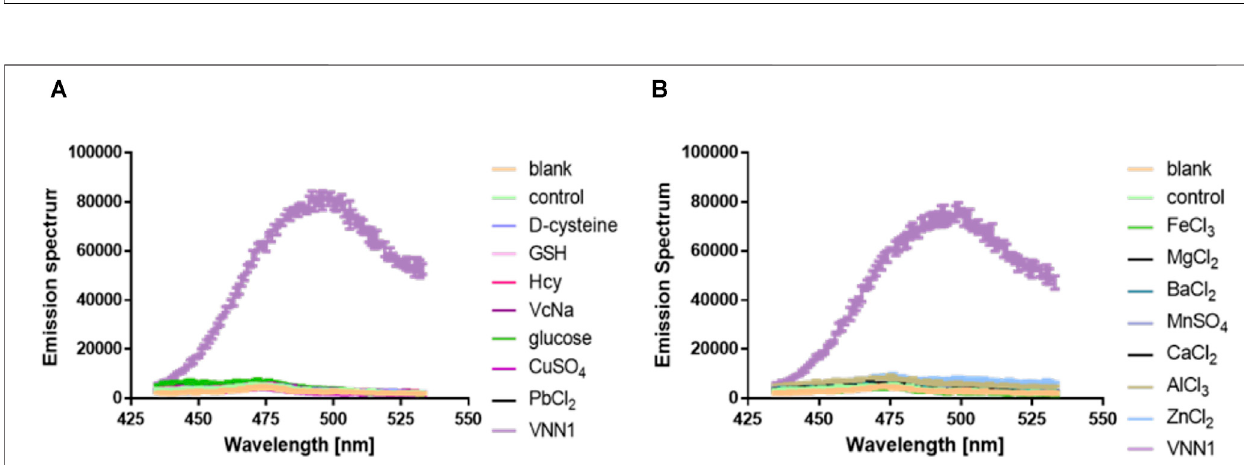
Frontiers in Chemistry |